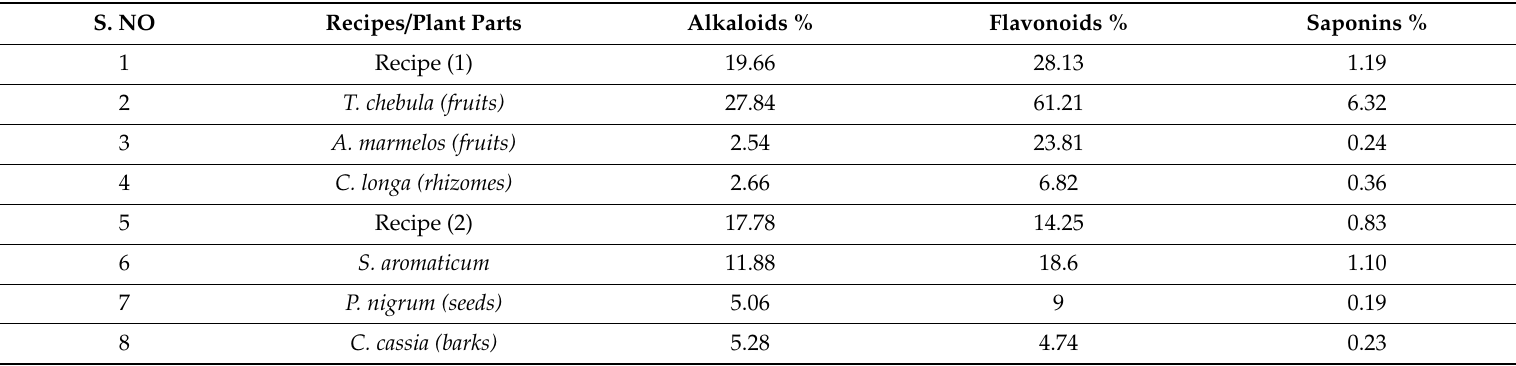
Table 2. Quantitative phytochemical screening of alkaloids, flavonoids and saponins of medicinal plant parts and their recipes. S.